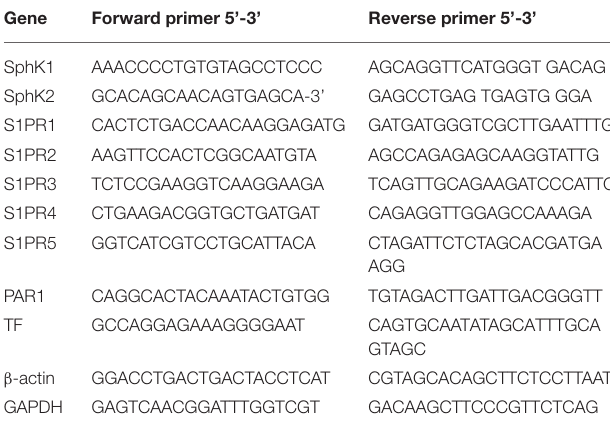
TABLE 1 | Sequences of PCR primers